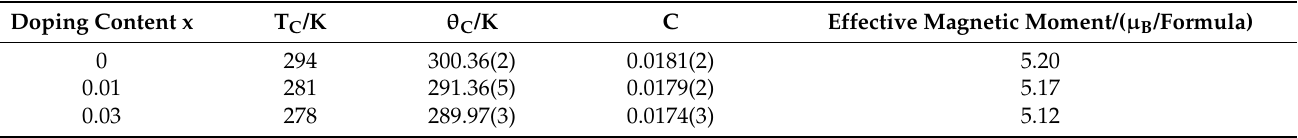
Table 4. Magnetic ordering temperature, T C ; Curie–Weiss temperatures, θ C ; Curie–Weiss constant, C; and effective moments, µ eff for all MnCoGe 1 − x La x